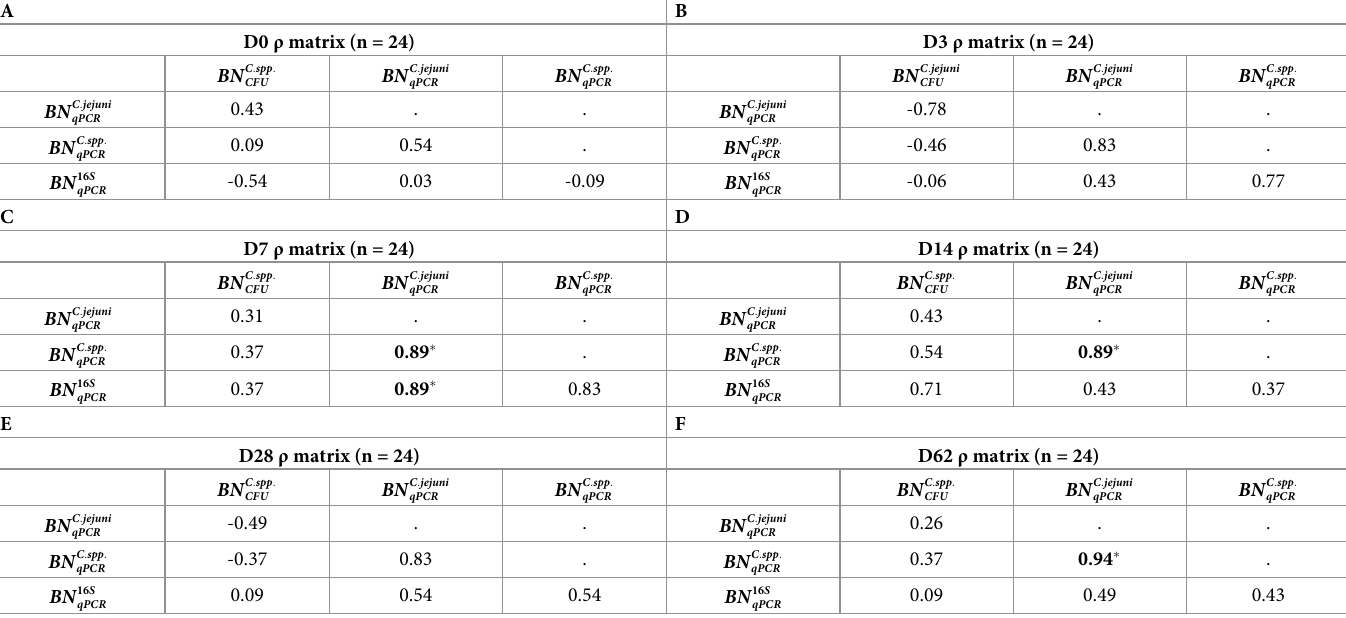
Where ρ = 1 depicts similarities between two ranking orders, ρ = 0 reflects an absence of correlations, and ρ = -1 shows opposite ranking. Statistically significant ( ρ � 1) is indicated in bold and with the ( � ) symbol.